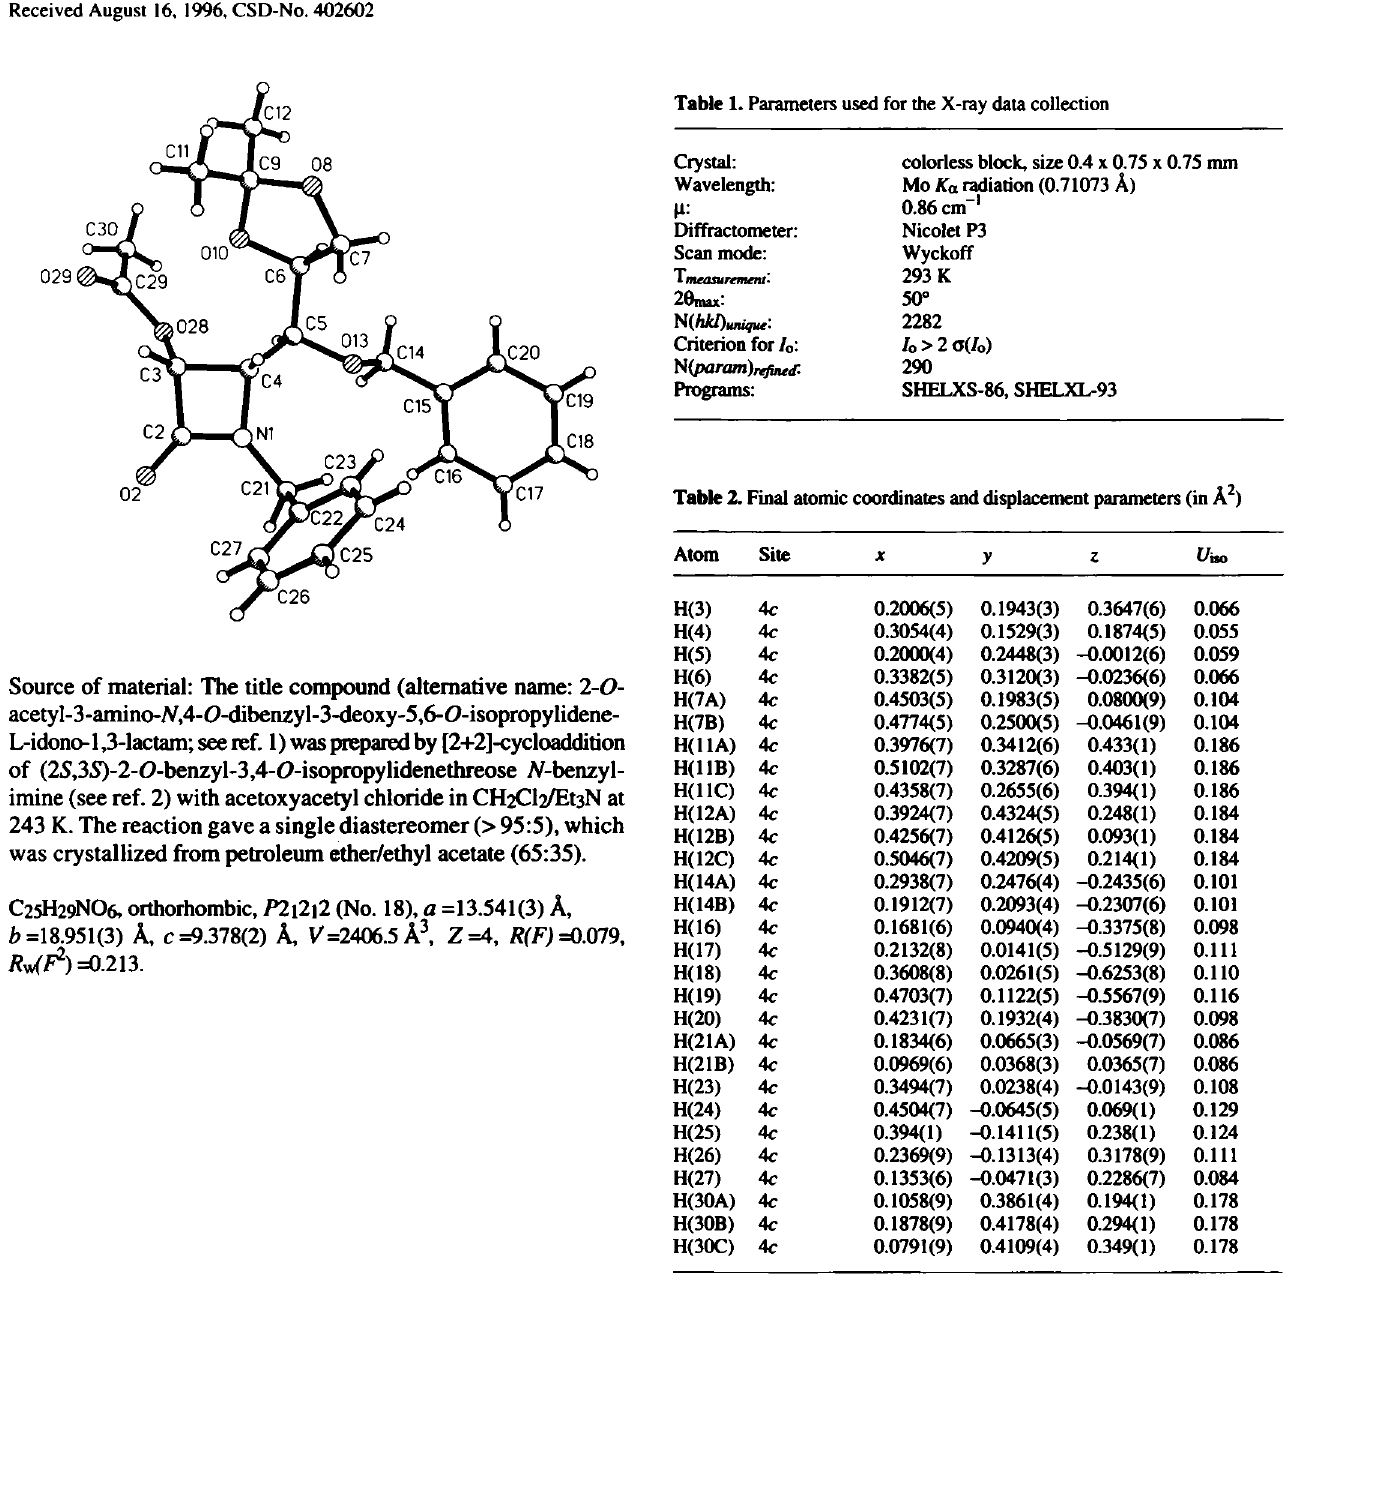
Table 1. Parameters used for the X-ray data collection